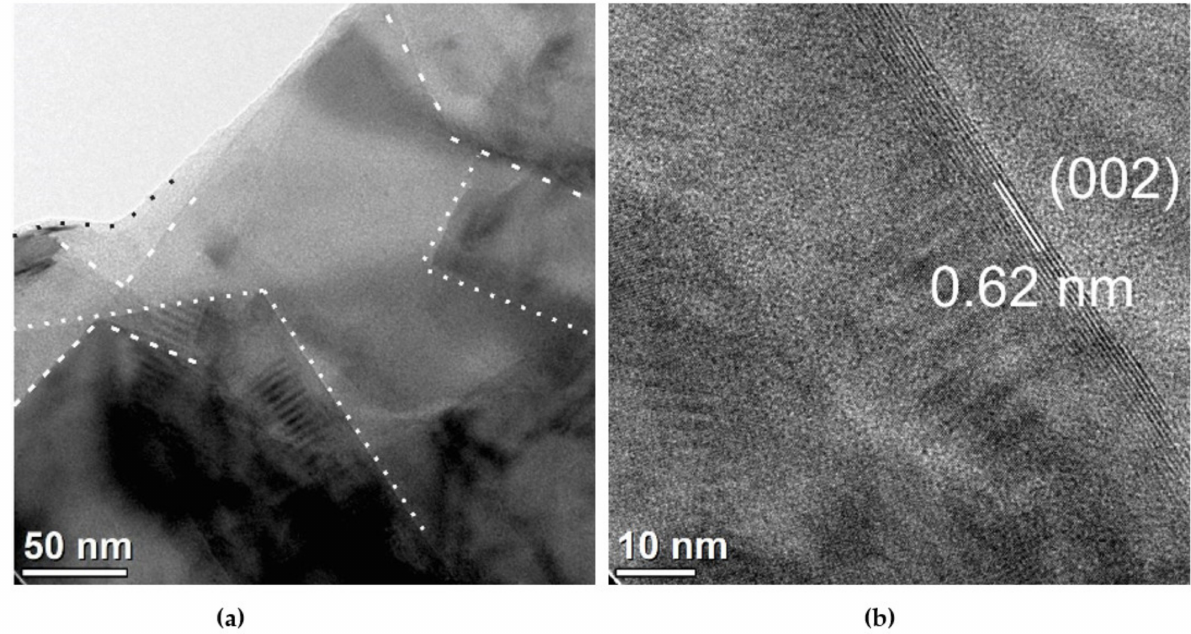
Figure 6. Morphological analysis of molybdenum disulfide film: ( a ) TEM and ( b ) HRTEM of the MoS 2